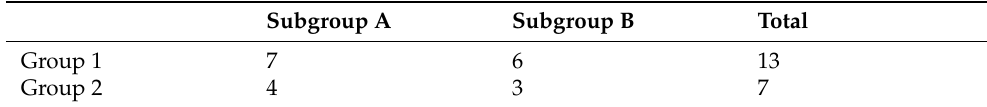
Table 2. Patients with fistulae without maxillary bone